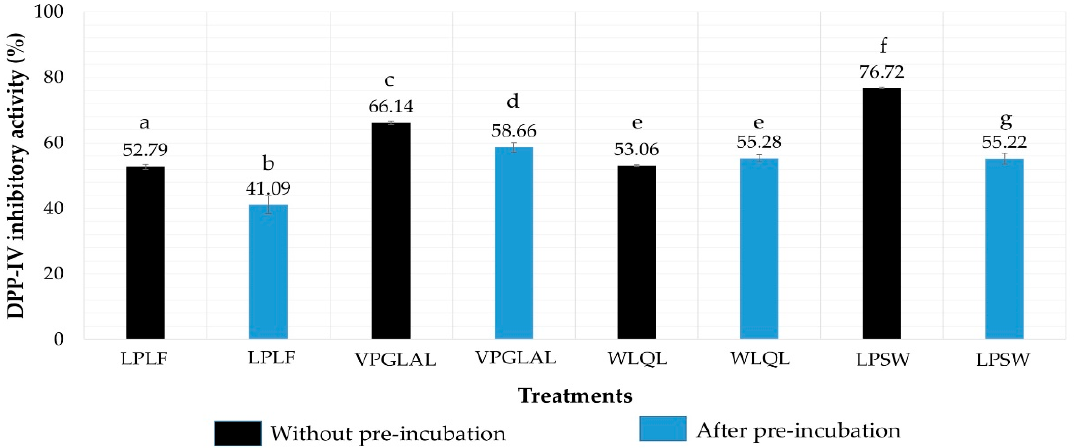
Figure 5. Pre-incubation experiment of LPLF, VPGLAL, WLQL, and LPSW. The error bars represent the standard deviation. Different letters (a–g) indicate significant differences between samples ( p < 0.05). The concentration for each peptide is 500 µM.